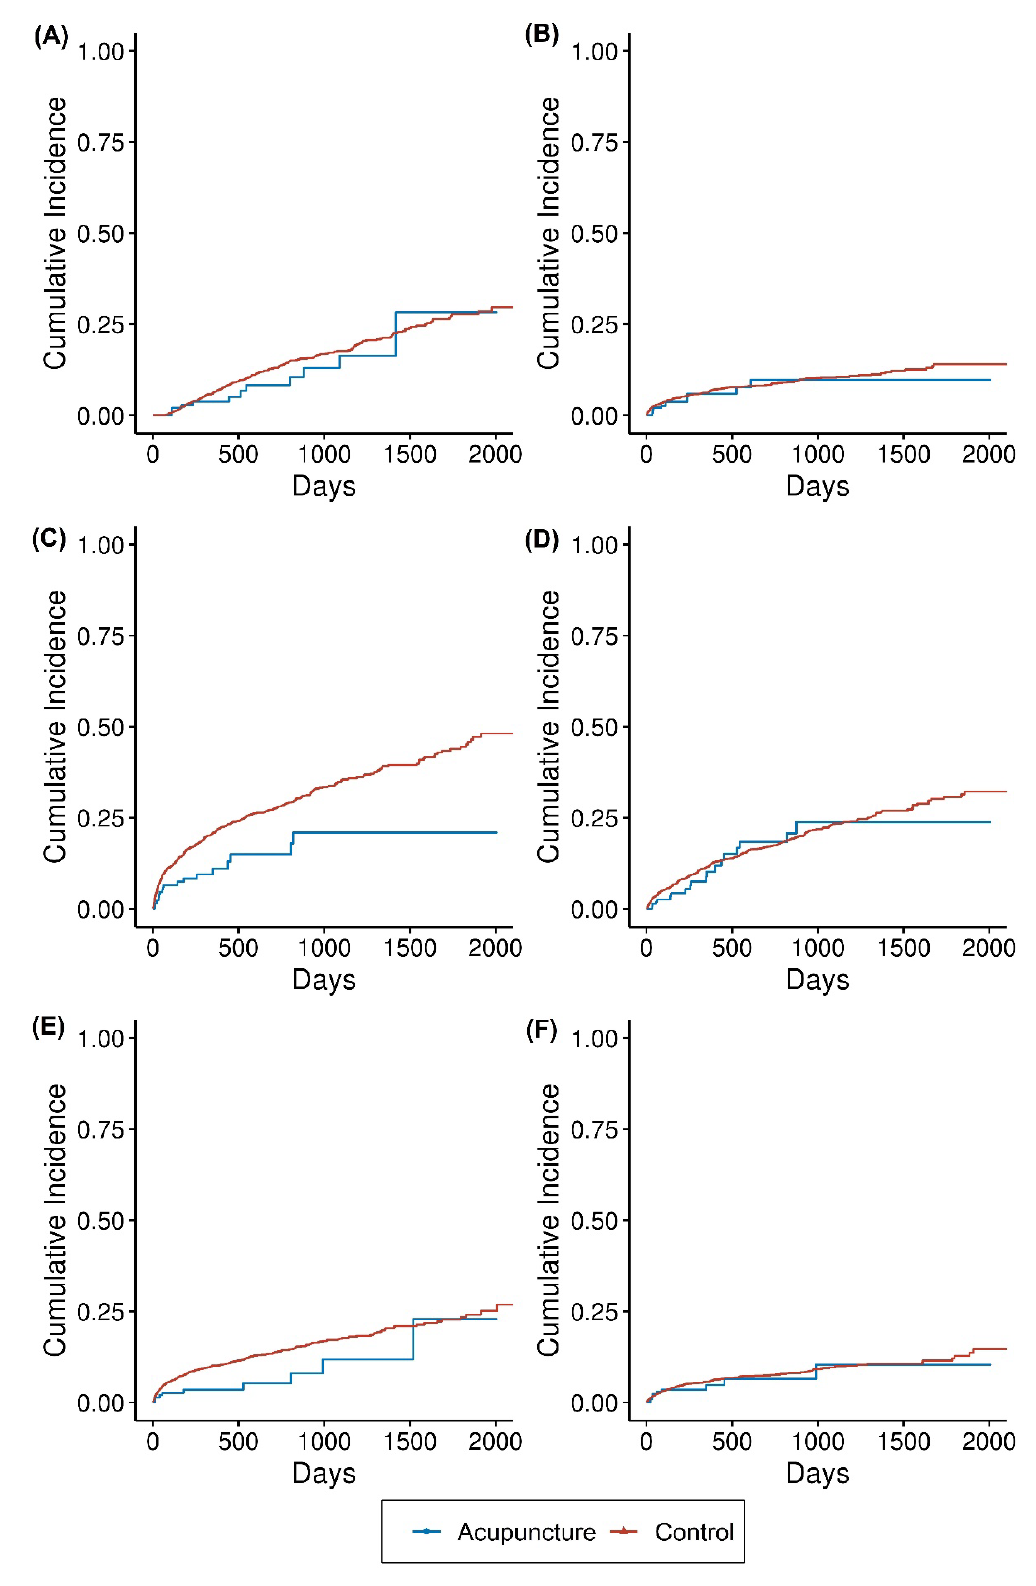
Figure 2. Extended Kaplan–Meier graph of the outcomes of the acupuncture and control groups. The cumulative incidence of each type of event is presented in the extended Kaplan–Meier graph. Events were ( A ) all-cause death, ( B ) readmission because of stroke relapse, ( C ) complications as a composite outcome, ( D ) pneumonia, ( E ) urinary tract infection, and ( F ) decubitus.